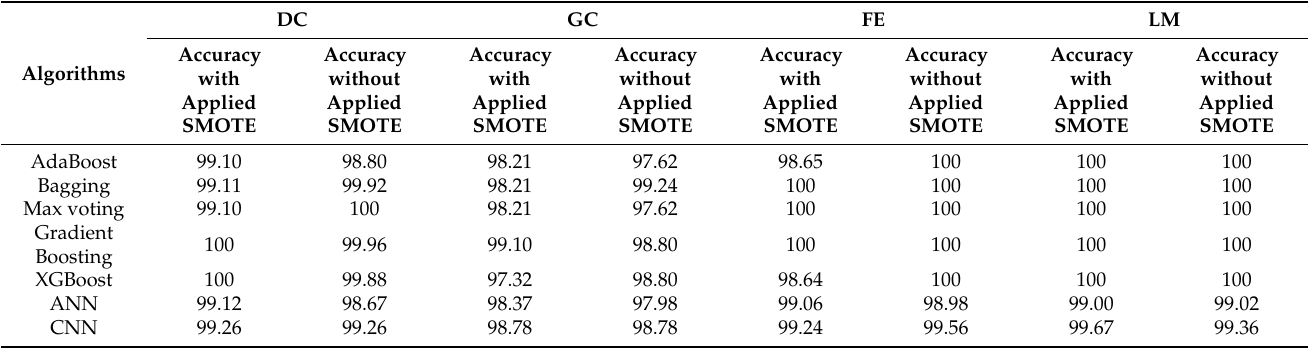
Table 14. Outcomes of Ensemble algorithms with and without applied